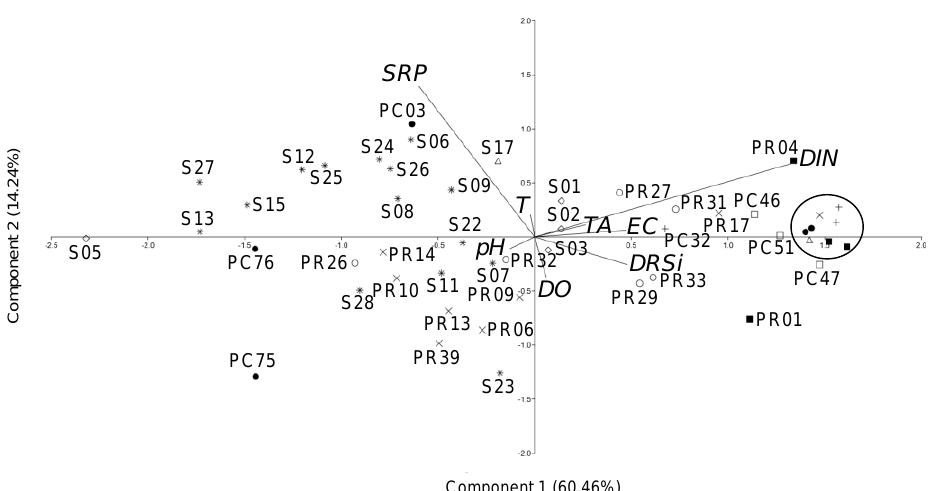
Figure 4. Principal component analysis (PCA) diagram representing the ordination of springs in relation to environmental variables. T: temperature; EC: electric conductivity; TA: total alkalinity; DO: dissolved oxygen saturation; SRP: soluble reactive phosphorus; DRSi: dissolved reactive silica; DIN: dissolved inorganic nitrogen. Point symbols refer to sub-catchments (Chiavenna:  ; Arda-Ongina: + ; Staffora-Luria-Versa-Coppa:  ; Taro:  ; Parma: X ; Enza:  ; Lambro-Olona meridionale:  ; Adda:  ; Po: 